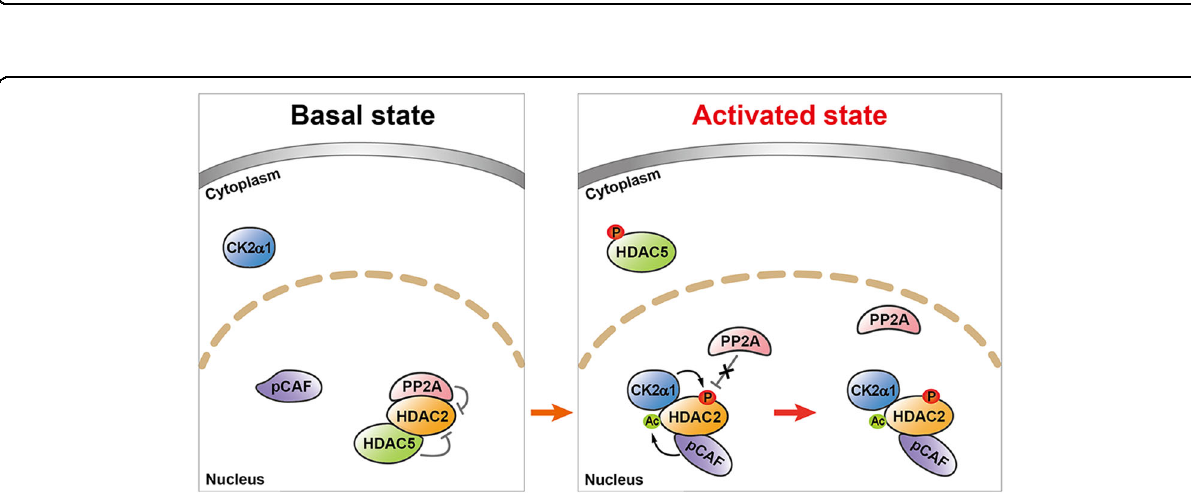
Fig. 8 Working hypothesis. The diagram shows the working hypothesis based on the present work and the previously established mechanisms to regulate HDAC2 activity in the development of cardiac hypertrophy. HDAC2, a class-I HDAC 49 , and its posttranslational modi fi cation play an important role in the development of cardiac hypertrophy. In the basal state, HDAC2 is kept unphosphorylated and deacetylated by its association with PP2A and HDAC5, respectively (present work). In the activated state induced by hypertrophic stimuli, HDAC5 is then phosphorylated and shuttles out from the nucleus 13 . Simultaneously, pCAF interacts with HDAC2 to induce its acetylation 17 . After the acetylation of HDAC2, hypertrophic stresses further induce both the dissociation of PP2A (present work) and cytosol-to-nuclear relocalization of CK2 α 1 16 , which simultaneously result in the phosphorylation of HDAC2 S394. For ease of understanding, the hypertrophy non-responsive basal phosphorylation of HDAC2 is not included in the present diagram. Abbreviations: Ac, acetylation. P,